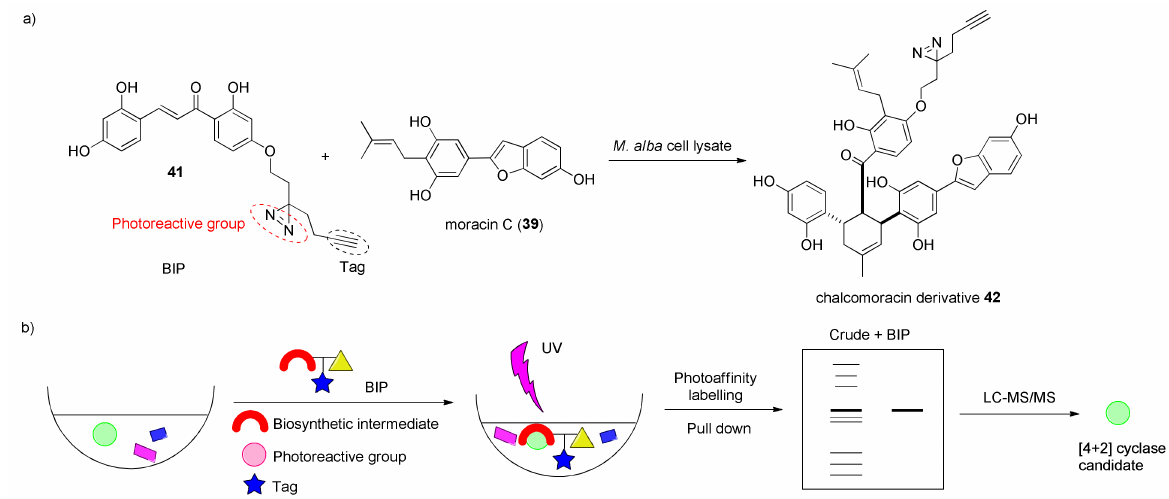
Figure 13. BIP-based identification method of putative [4+2] pericyclase from Morus alba